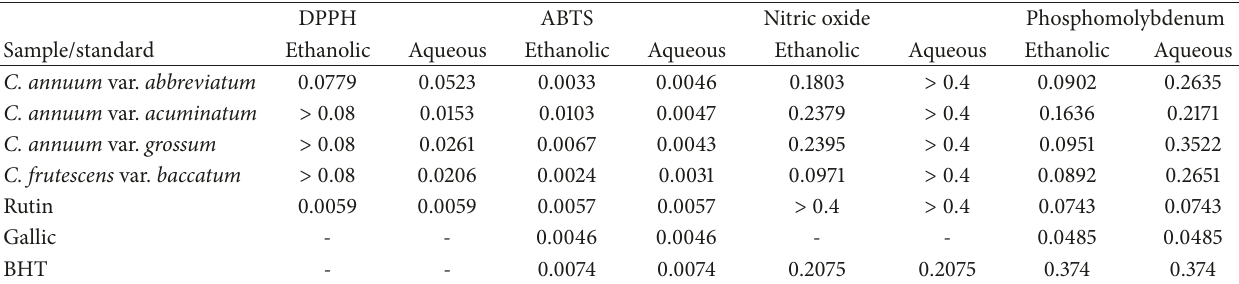
Table 3: IC 50 values of the varieties of Capsicum spp. extracts and standard drugs. DPPH ABTS Nitric oxide